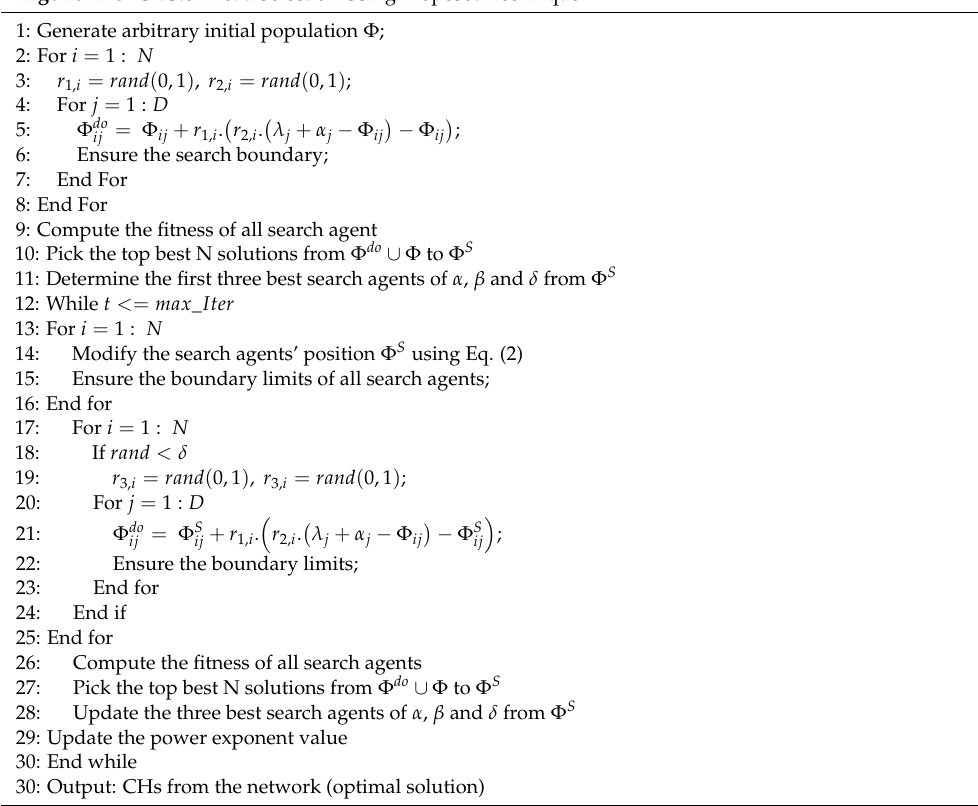
Algorithm 3 . Cluster Head Selection Using Proposed Technique.